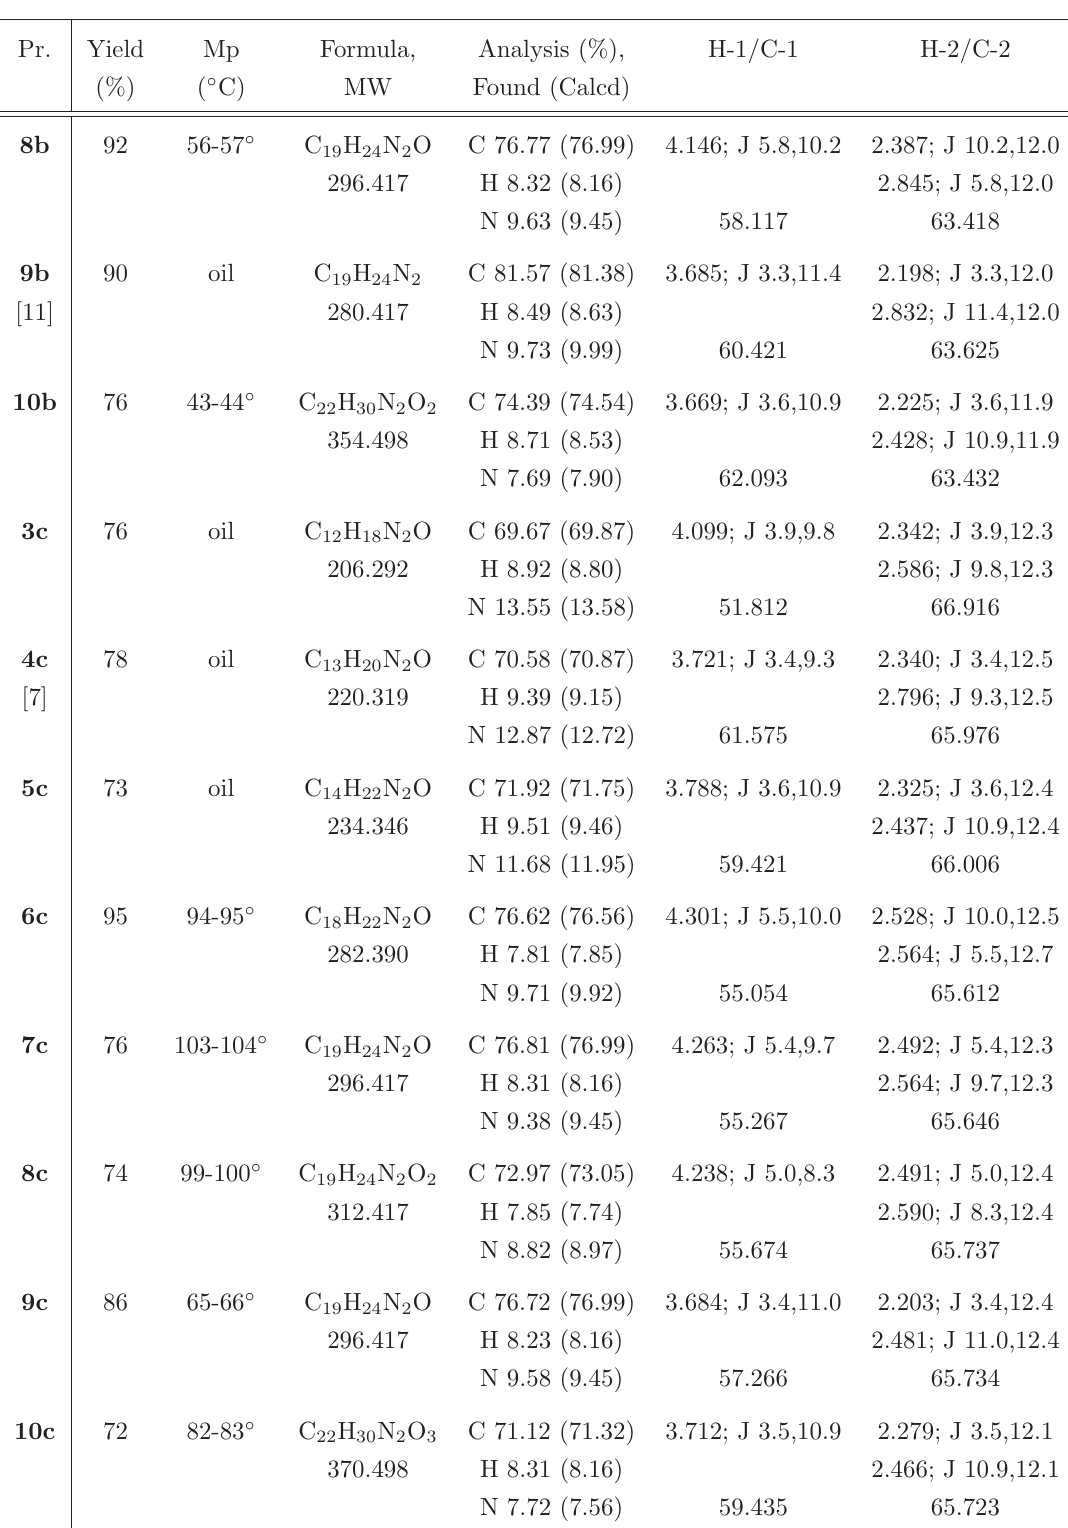
Table 2 (continue) Analytical and NMR data (CDCl 3 , δ referenced to TMS as an internal standard, J in Hz) of the skeleton nuclei of diamines 3 – 10